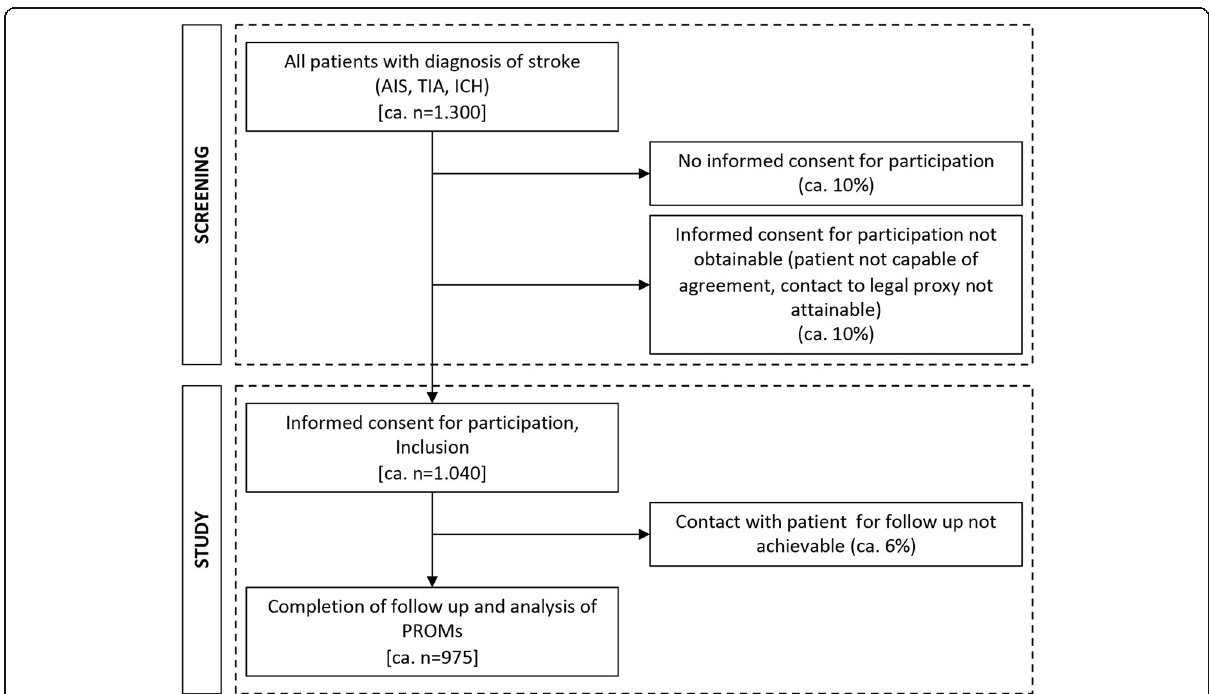
Fig. 1 Estimated number of included patients after recruitment. Abbreviations: AIS acute ischemic stroke, TIA transient ischemic attack, ICH intracerebral